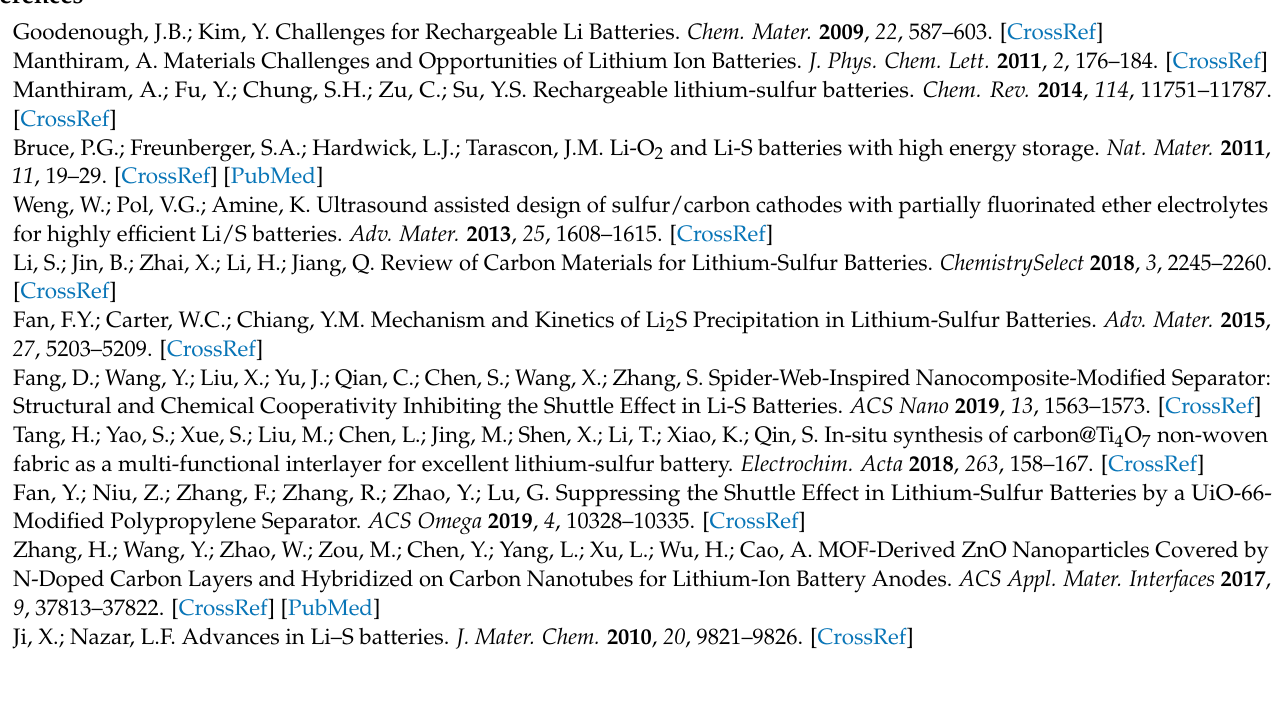
Figure S2. Raman spectroscopy of Ketjenblack. Figure S3. XPS photoelectron spectroscopy of cotinine black positive carrier material (a) full spectrum of cotinine black (b) C1s fine spectrum (c) O1s fine spectrum. Figure S4. XRD of Ketjenblack. Figure S5. (a) KB/S positive cyclic curve. (b) Cycle platform curve of KB/S positive pole under different cycle numbers. Figure S6. AC